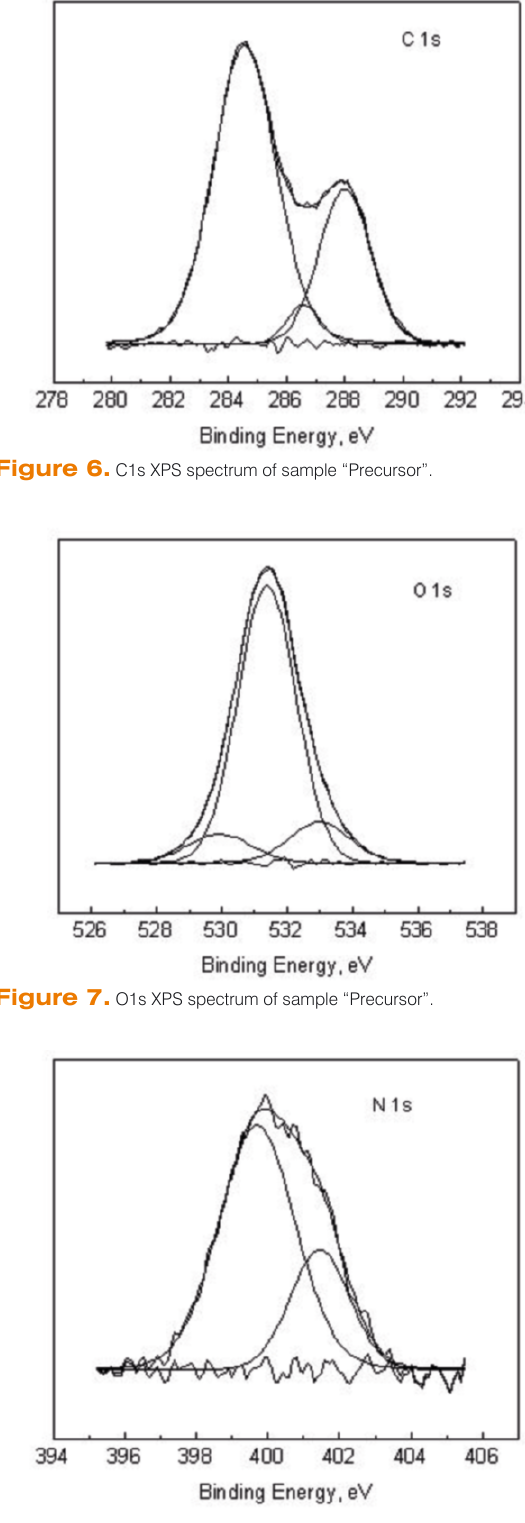
Figure 8. N1s XPS spectrum of sample